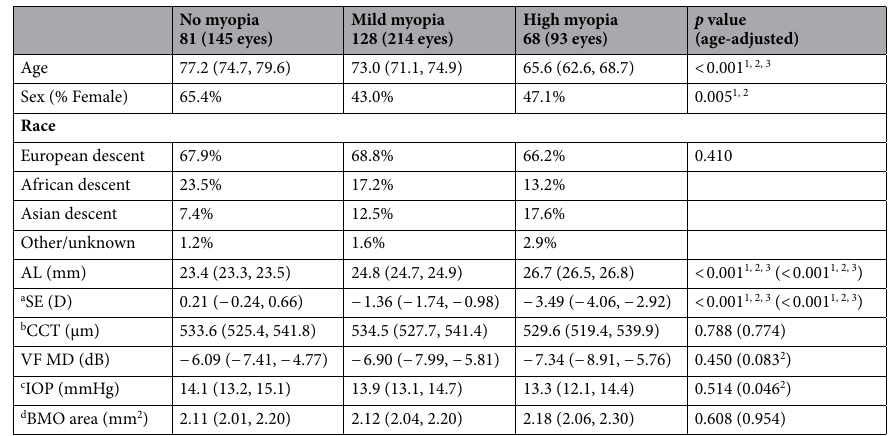
Table 1. Glaucoma patient and eye characteristics by myopia group. Results are presented as mean (95% confidence interval) or percentage. Race was compared using a chi-squared test. Continuous variables were compared using ANOVA (for age) or linear mixed models (for eye level data). No myopia: AL ≤ 24.0 mm; Mild myopia: AL: > 24 mm and ≤ 26.0 mm; High myopia: AL > 26.0 mm. Missing 66 a , 14 b , 2 c , and 28 d values. 1 No versus Mild Myopia p < 0.05; 2 No versus High Myopia p < 0.05; 3 Mild versus High Myopia p < 0.05. AL, axial length; BMO, Bruch’s membrane opening; CCT, central corneal thickness; IOP (intraocular pressure); SE, spherical equivalent; VF MD, visual field mean